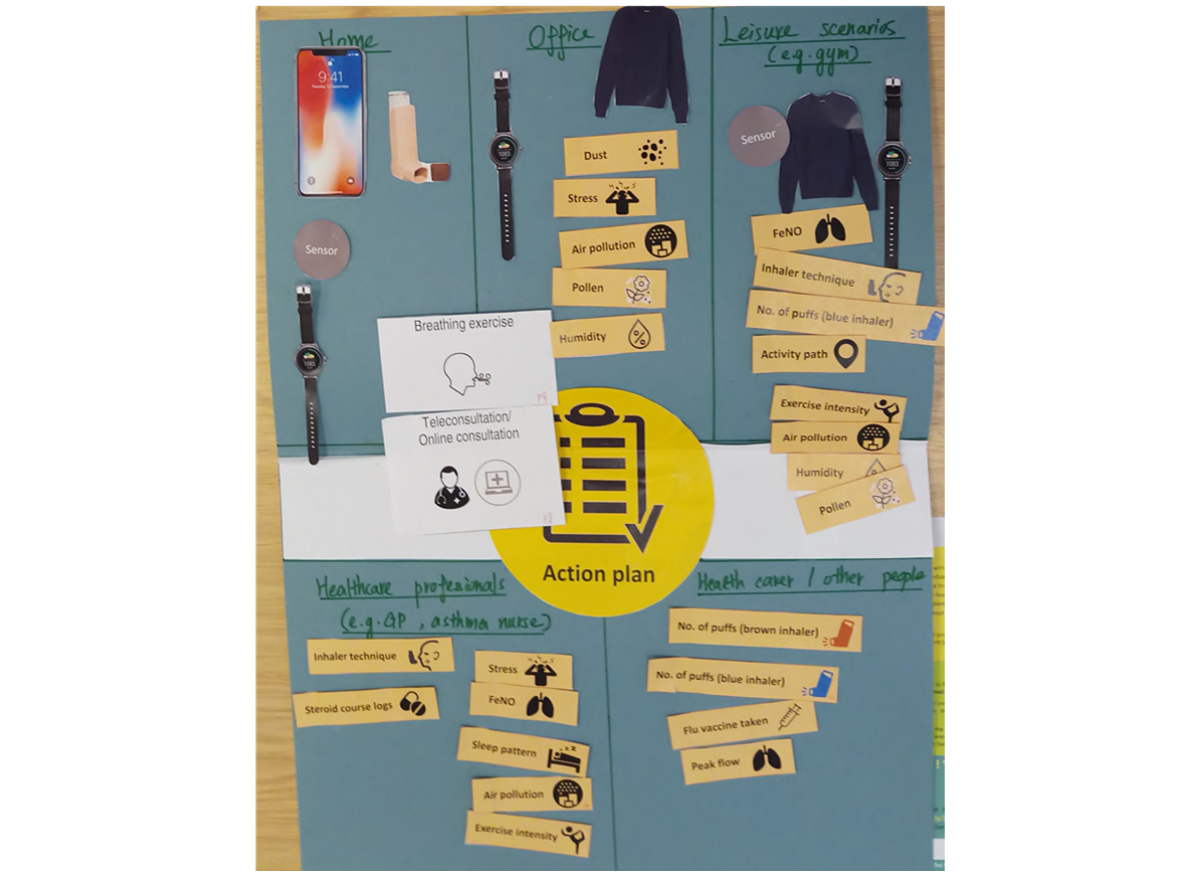
Figure 1. An example of a task completed by a